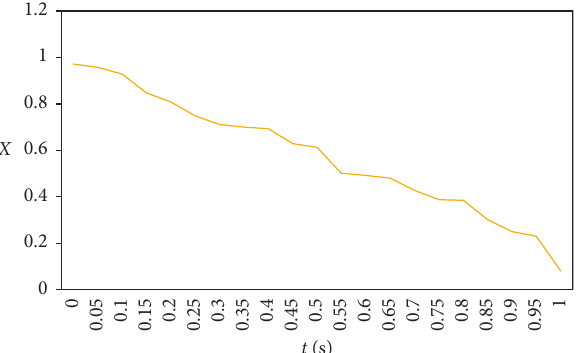
Figure 7: The x of the DMP standard Internet of Health Things system attenuates with t